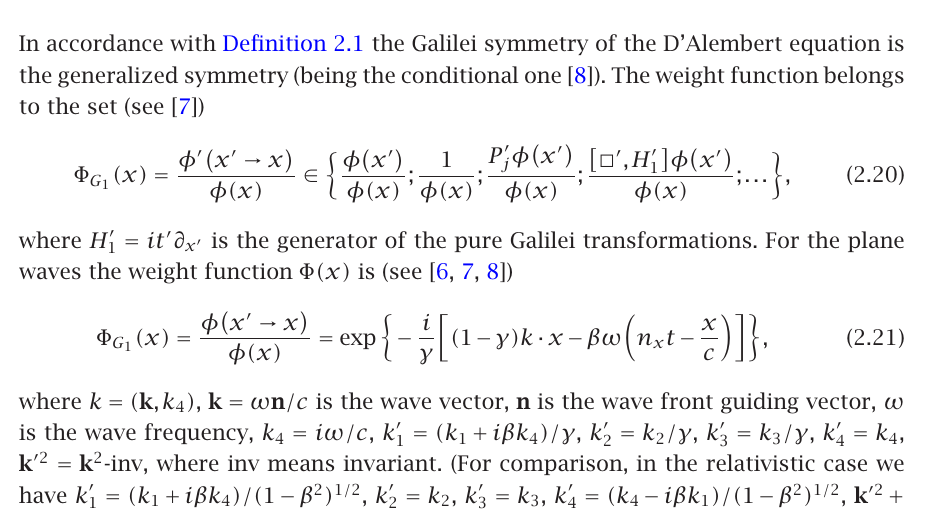
= (k + iβk )/ρ( 1 − β 2 ) 1 / 2 , k (cid:1) = k /ρ 1 4 2 1 2